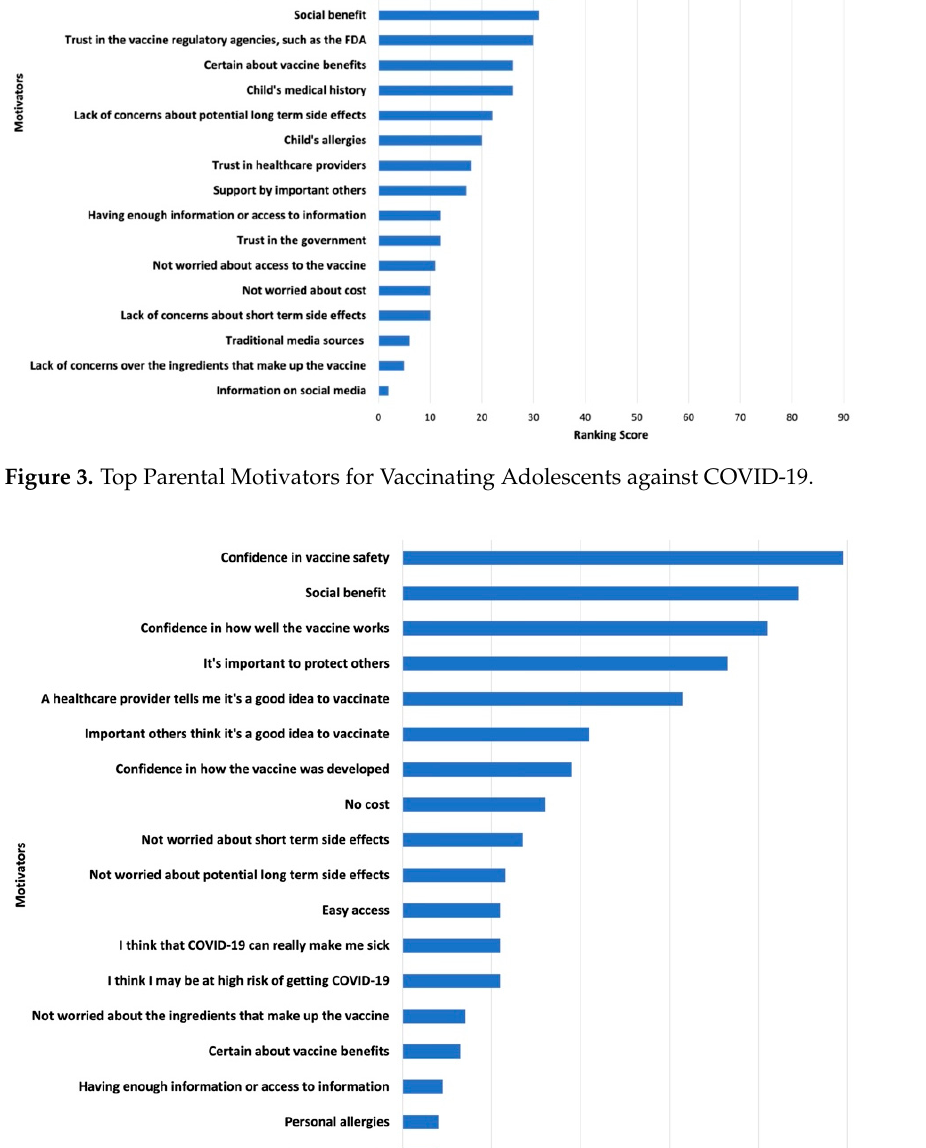
Figure 4. Top Adolescent Motivators for Vaccinating against COVID-19.